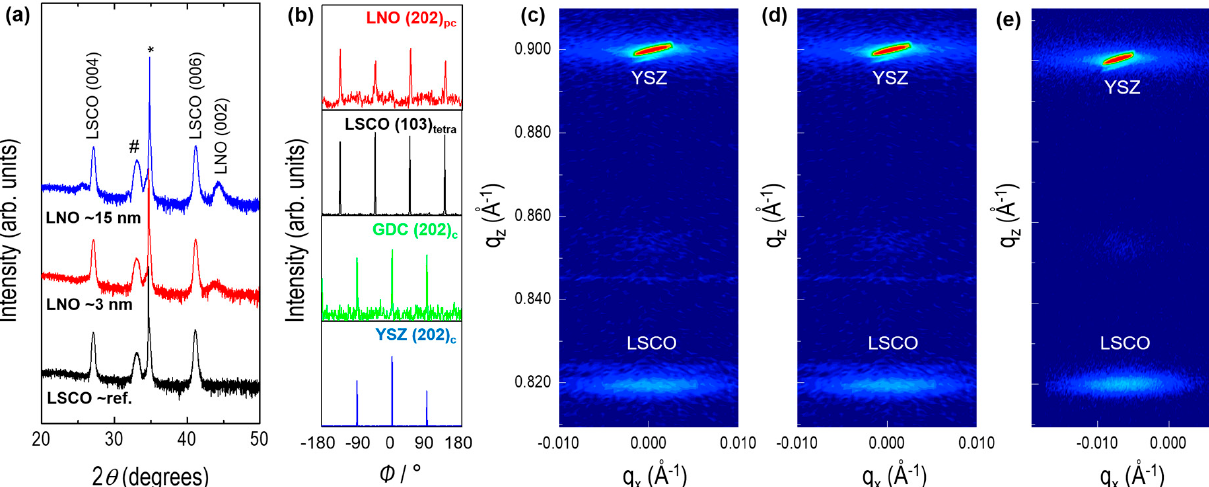
Figure 1. ( a ) XRD θ –2 θ patterns of the epitaxial reference LSCO and LNO-decorated LSCO films; ( b ) XRD φ scans of the 202 reflection of a YSZ substrate, a GDC buffer layer (~20 nm), and a LNO film (~15 nm), and of the 103 reflection of a LSCO film (~60 nm). GDC and YSZ substrate peaks are indicated with # and *, respectively. RSMs around the 2 2-4 Bragg peak from YSZ of ( c ) reference LSCO, ( d ) ~3nm LNO-decorated LSCO, and ( e ) ~15 nm LNO-decorated LSCO film.